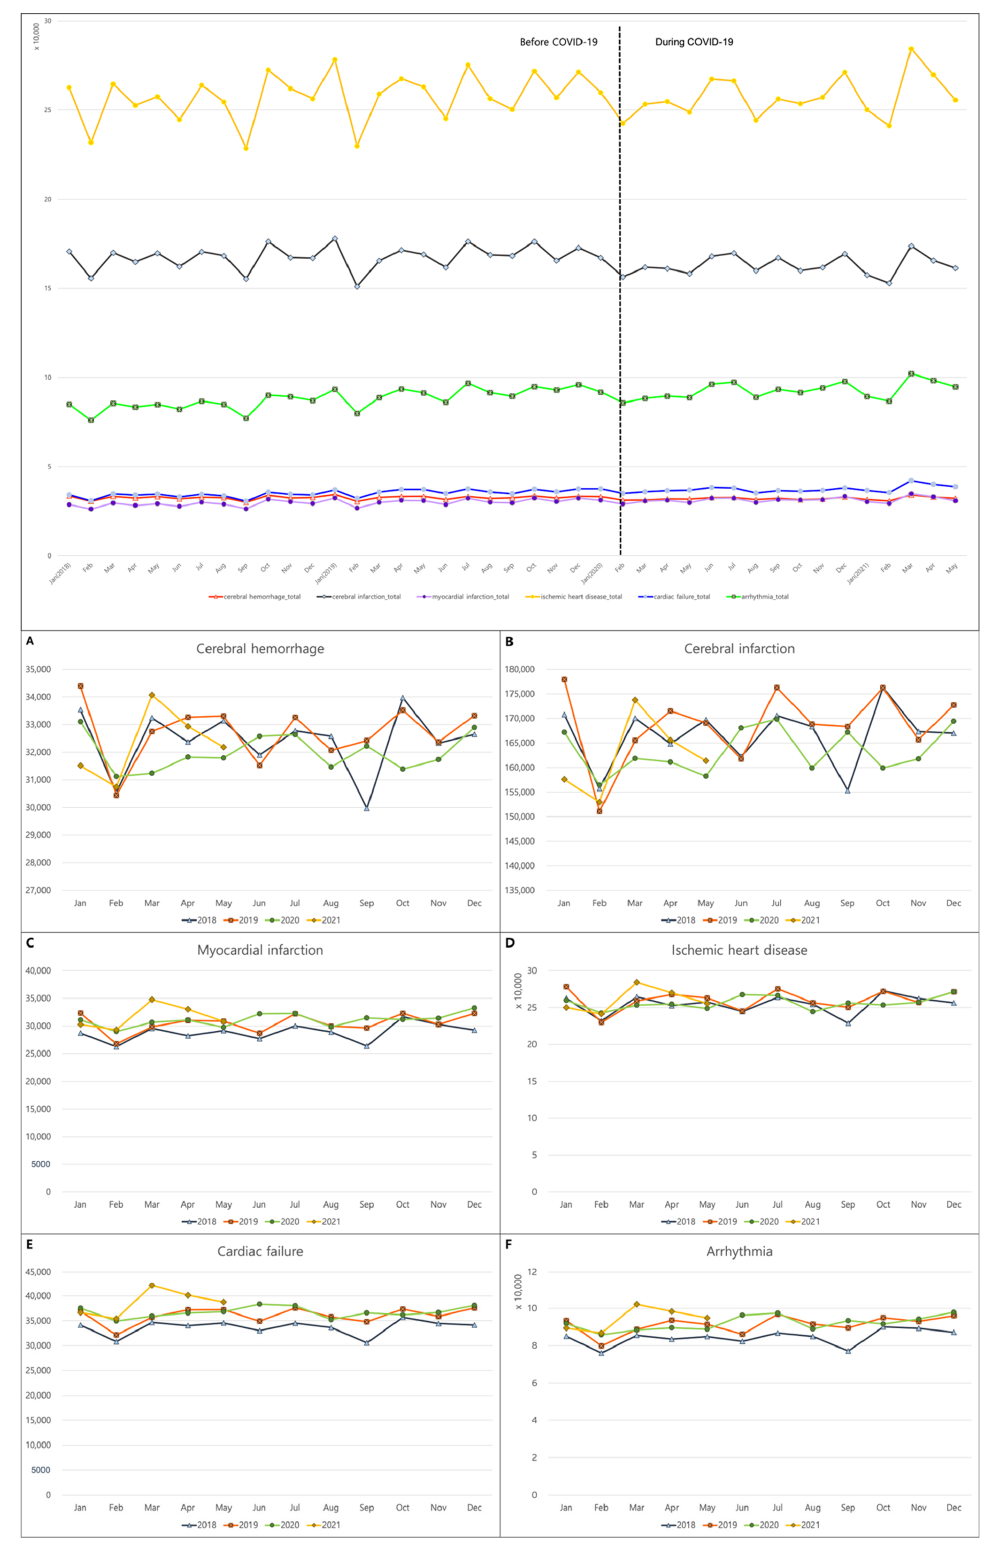
Figure 1. Monthly incidence of cardiovascular diseases during 2018, 2019, 2020, and 2021. The incidences of ( A ) cerebral hemorrhage; ( B ) cerebral infarction; ( C ) myocardial infarction; ( D ) ischemic heart disease; ( E ) cardiac failure; and ( F )